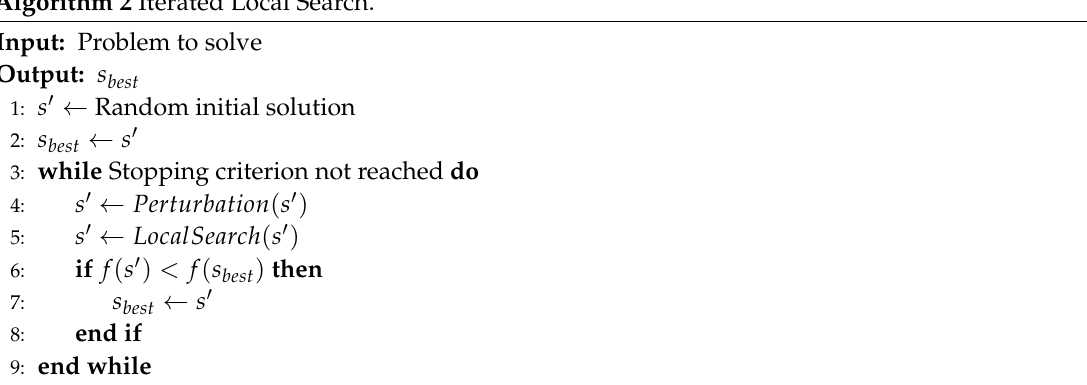
Algorithm 2 Iterated Local Search.